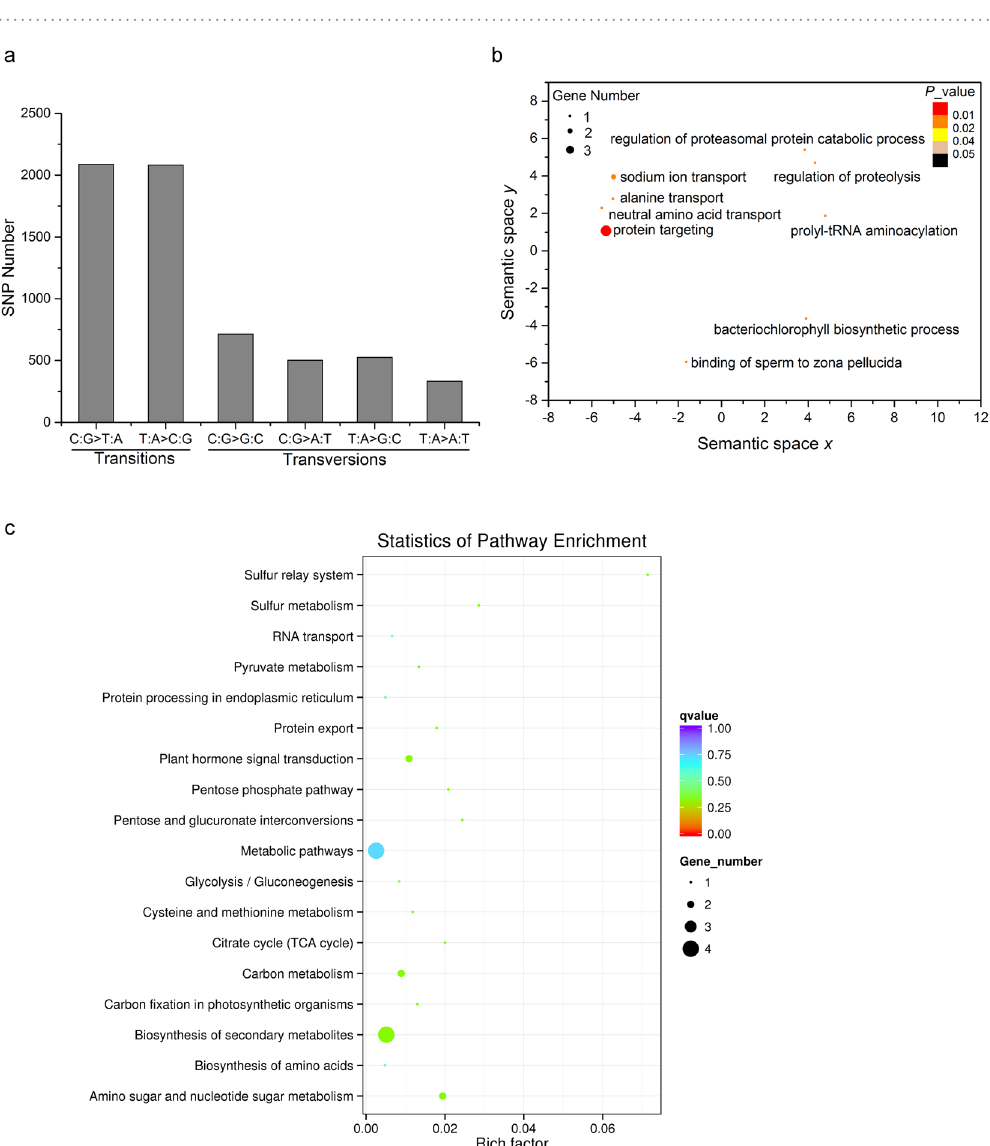
Figure 2. The characteristics of SNPs and GO terms and KEGG pathways enriched in st1 mutated genes. ( a ) Numbers of specific types of SNPs in the transcriptome of the spaceflight-induced mutant st1 ; ( b ) The top ten GO terms enriched in genes with termination and missense mutations determined based on the lowest over-represented p values were analyzed by REVIGO. Circles in closer proximity have GO terms that are more closely related. The size of the circle indicates the number of mutated genes. The color of the circle represents the statistical significance of the enriched GO terms based on the over-represented p value; ( c ) The KEGG pathways enriched in genes with termination and missense mutations. The rich factor reflects the proportion of mutated genes in a given pathway. The number of mutated genes in the pathway is indicated by the circle area, and the circle color represents the ranges of the corrected P